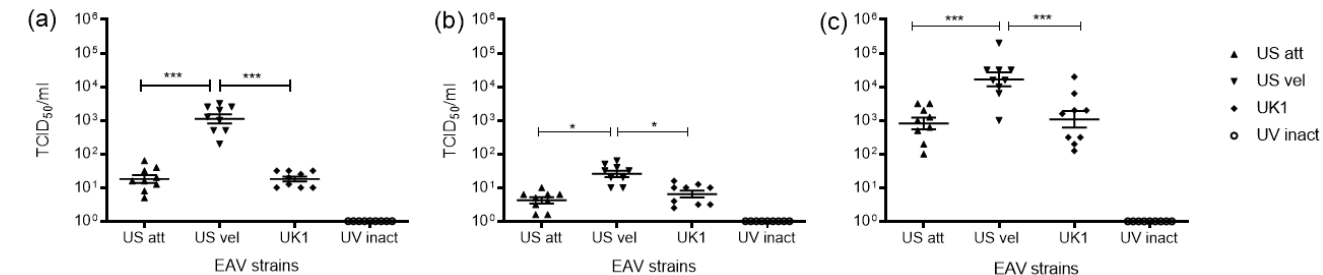
Figure 2. Viral infectivity titers from supernatants of infected Mo and MoDC cultures titrated on EEL. Monocytes ( a ), immature MoDC (iMoDC) ( b ), and mature (mMoDC) ( c ) were inoculated at MOI 5 with different strains of live or UV inactivated EAV. Virus titrations were performed on 0 and 16 hpi supernatants. The TCID50/mL at 0 hpi was subtracted from the TCID50/mL at 16 hpi. For all cells the TCID50/mL was the highest with the Velogenic strain. Overall, the titers were the highest in mMoDC followed by Mo and the least in iMoDC cultures. Results represent the TCID50/mL ± SEM ( n = 9). A two-tailed paired Student t test was used for single comparisons between the 0 and 16 hpi titers (shown in black). A 1-way ANOVA with Dunn’s multiple comparison test was used for comparisons between strains at 16 hpi (shown in red). * and *** indicate significant differences between sample means where p < 0.05 and 0.0001, respectively.